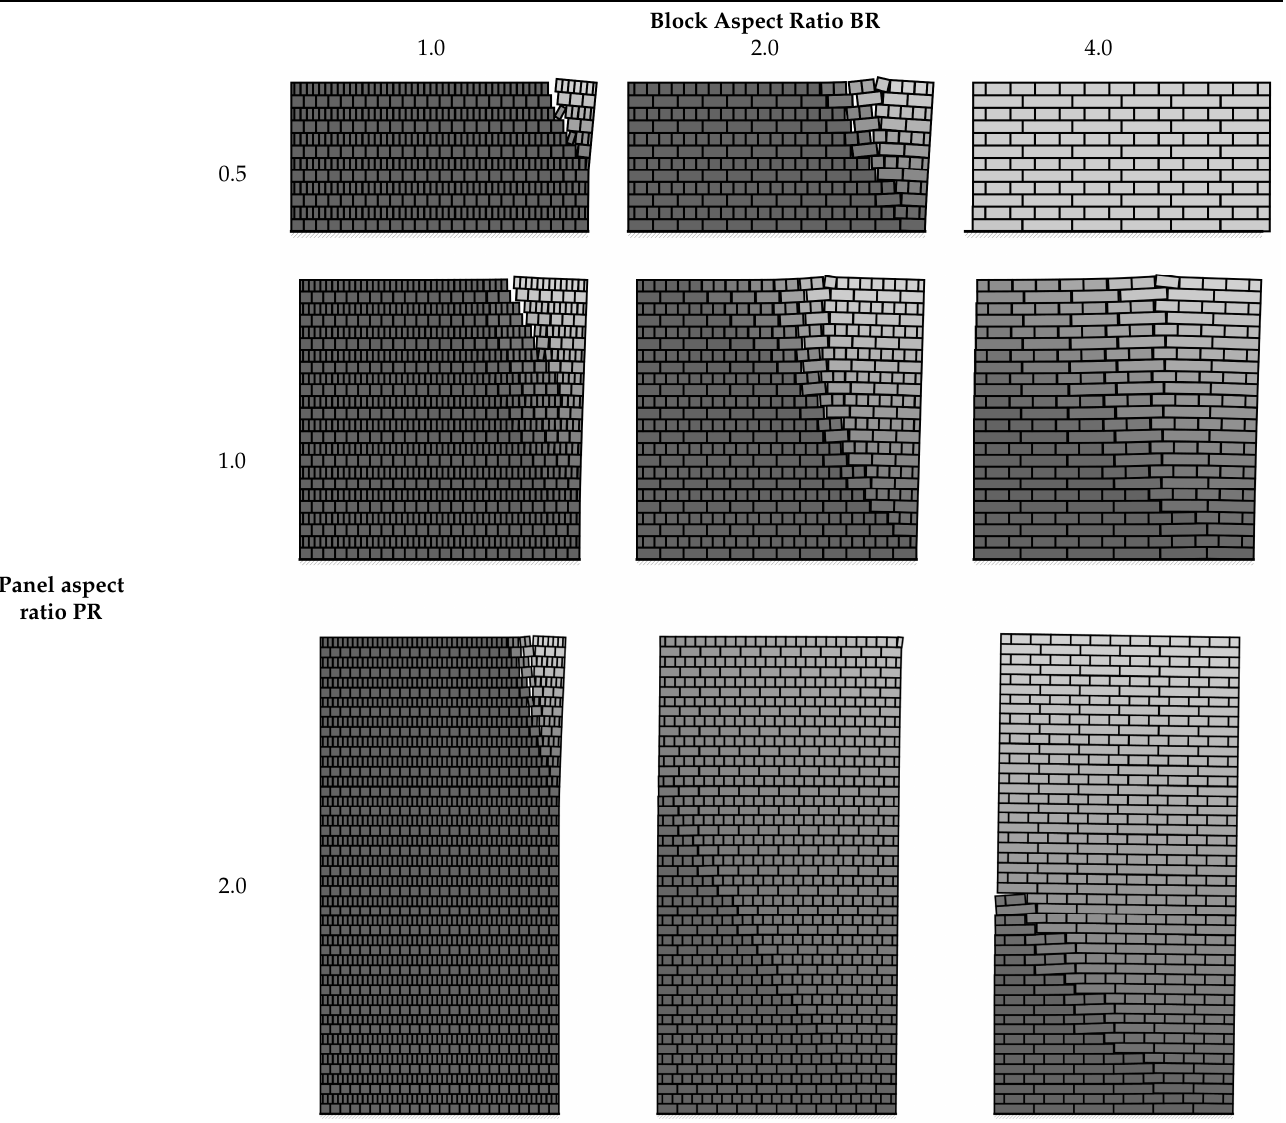
Table A8. Failure Mechanisms for English Bond with µ = 0.65.